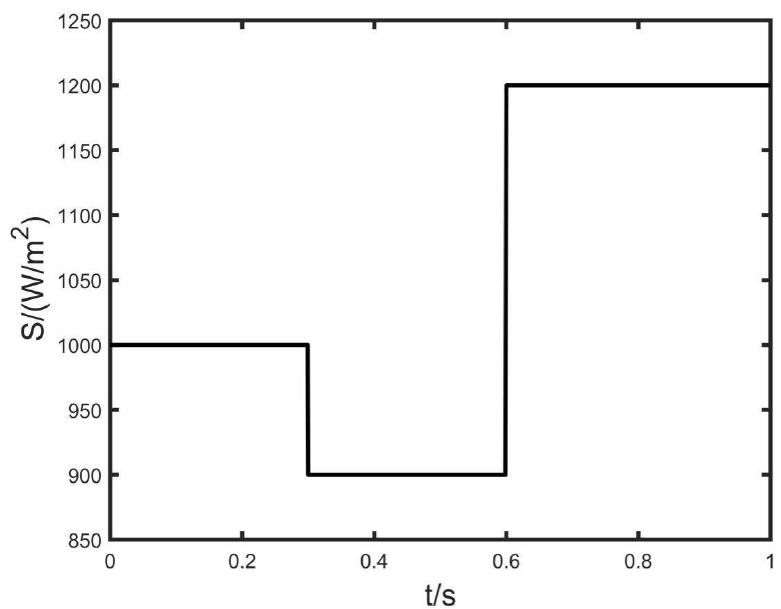
Figure 7. Variation curve of photovoltaic array light intensity.